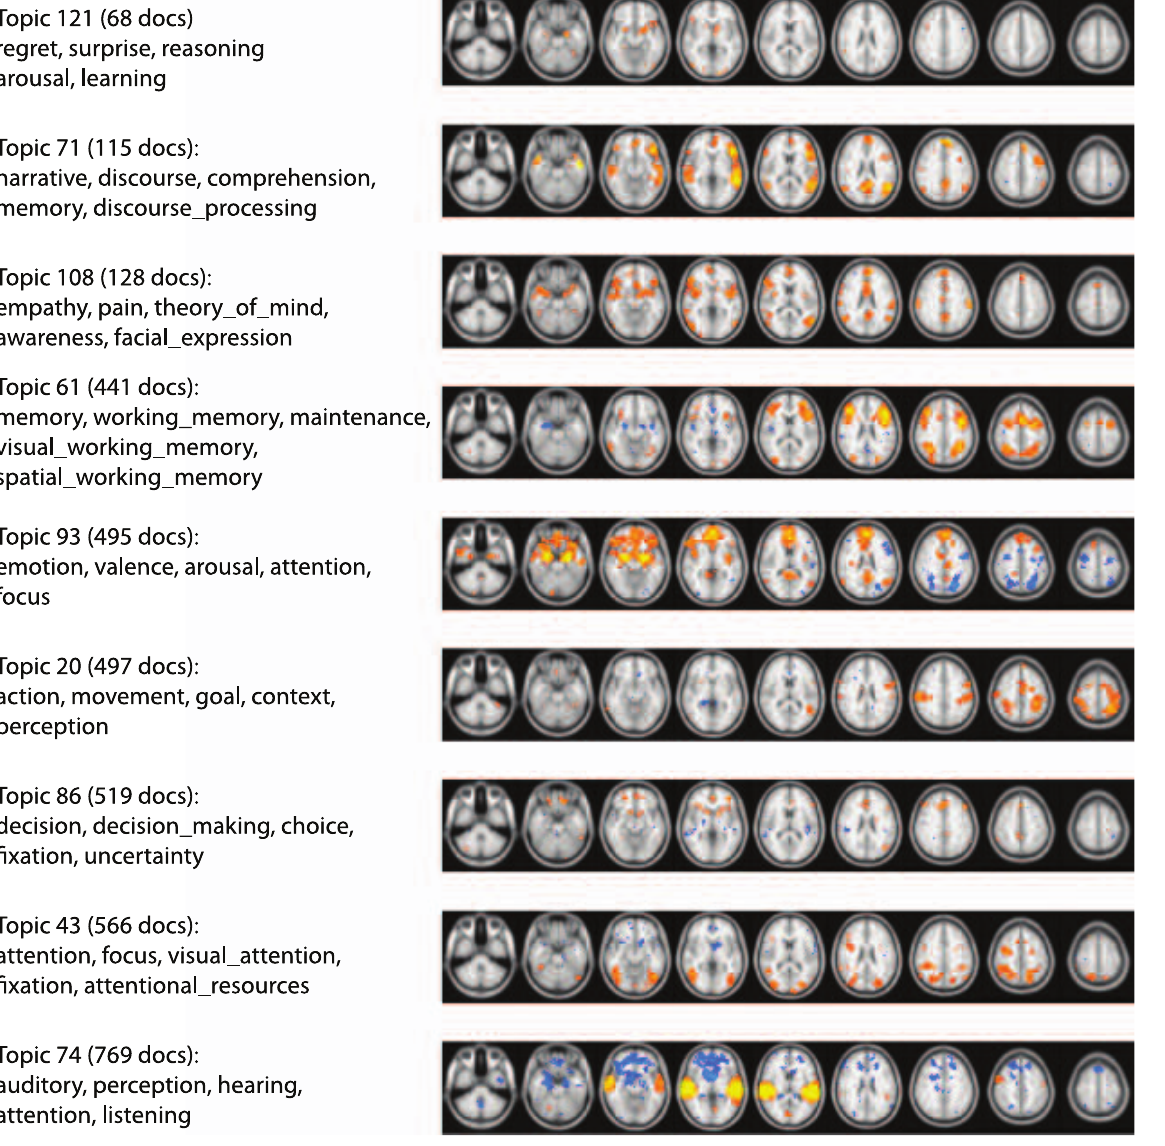
Figure 4. Examples of mental function topics and associated topic maps. The left panel shows the top words associated with each topic, and the right panel shows a map of voxels that were significantly associated with loading on that topic across documents. The image intensity is proportional to the Pearson correlation between the activation vector and the topic loading vector at each voxel (with red-yellow depicting positive correlations and blue-white depicting negative correlations), thresholded using a whole brain false discovery rate of q v .01. The topics are shown in order of descending number of documents with nonzero loadings on the topic; those at the top showed loading on a relatively small number of documents, whereas those at the bottom showed loading across a broader set of documents. The images are presented in radiological convention (i.e., left-right reversed).